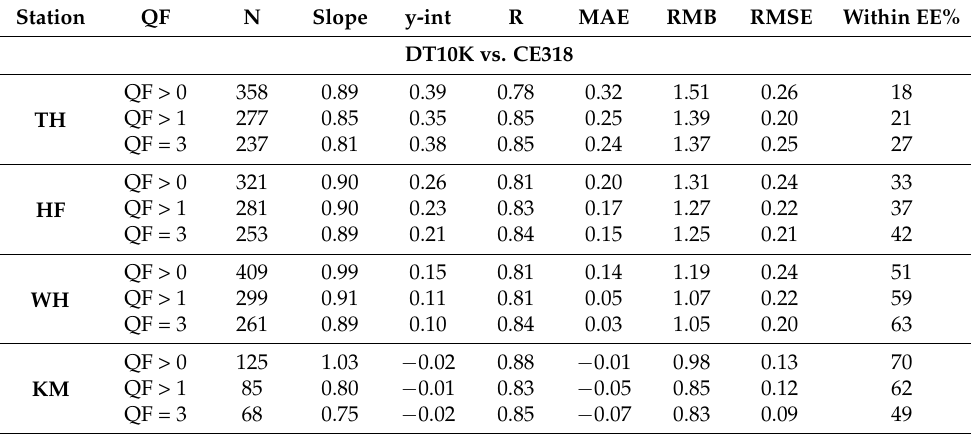
Table 4. As in Table 3, but comparison of the DT10K AOD